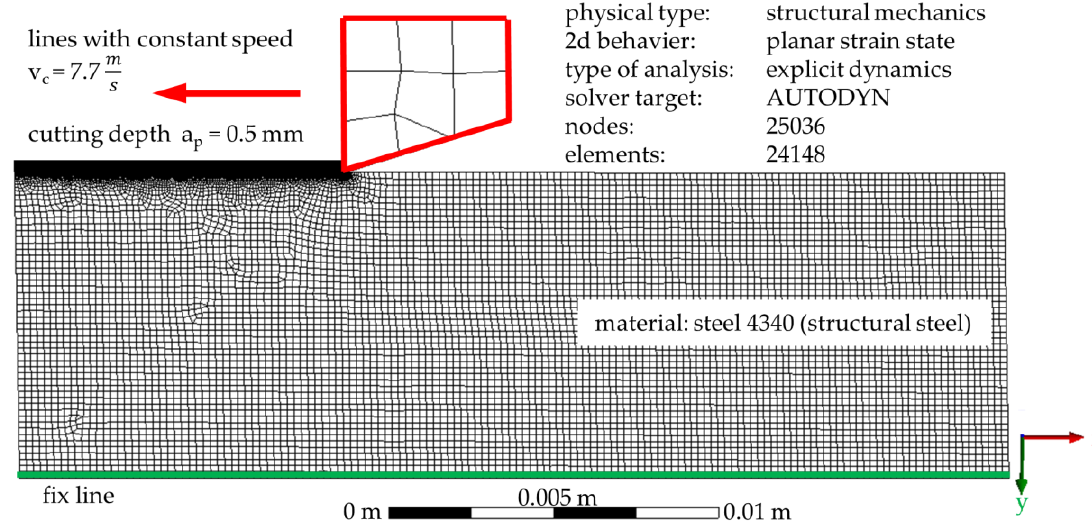
Figure 5. Geometry model of the milling process for finite element method (FEM) simulation.